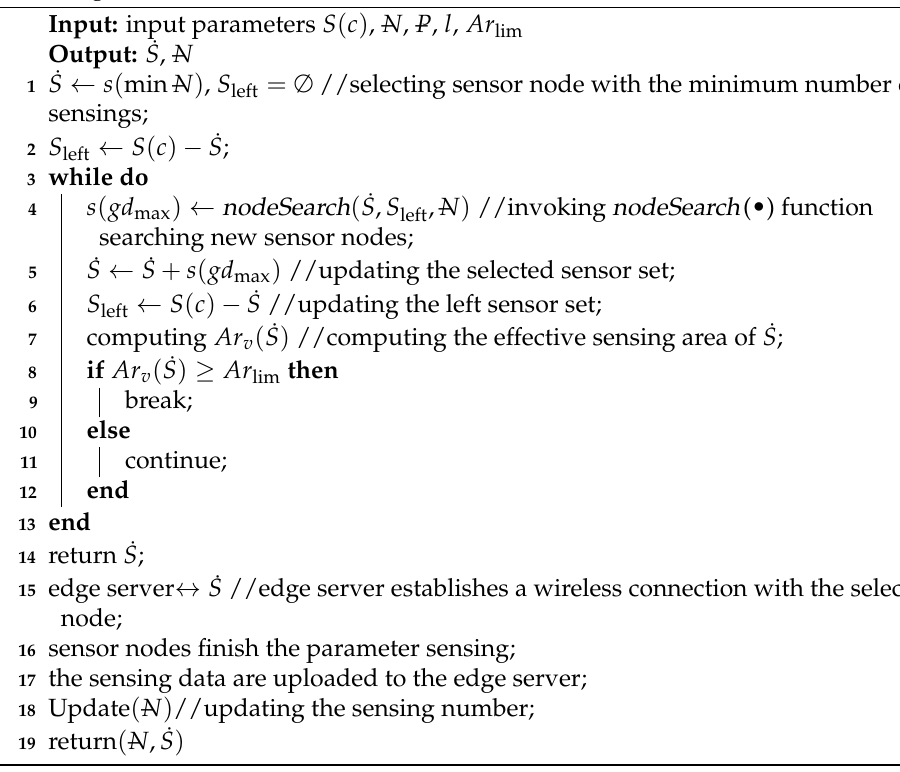
Algorithm 2: An adaptive working strategy of sensing nodes with effective sensing area